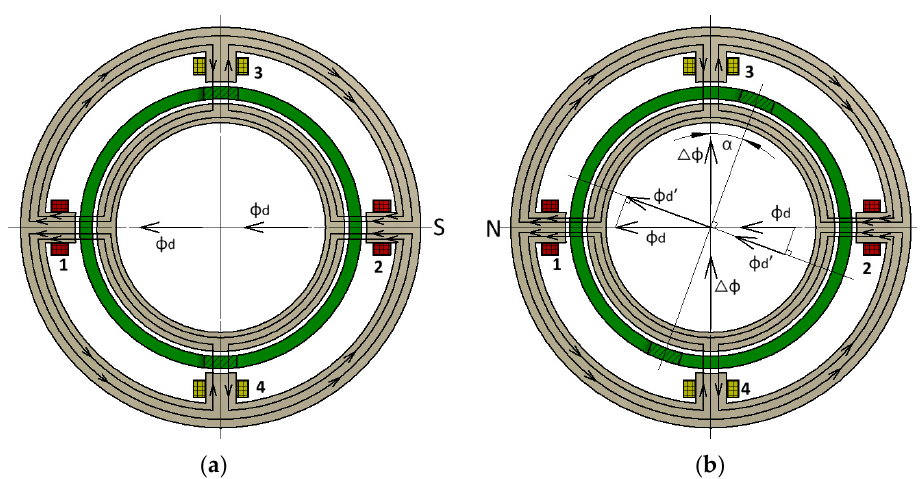
Figure 2. Instantaneous magnetic flux distribution: ( a ) magnetic flux distribution in the null position; ( b ) magnetic flux distribution when the rotor moves clockwise by an angle of α away from the null position.